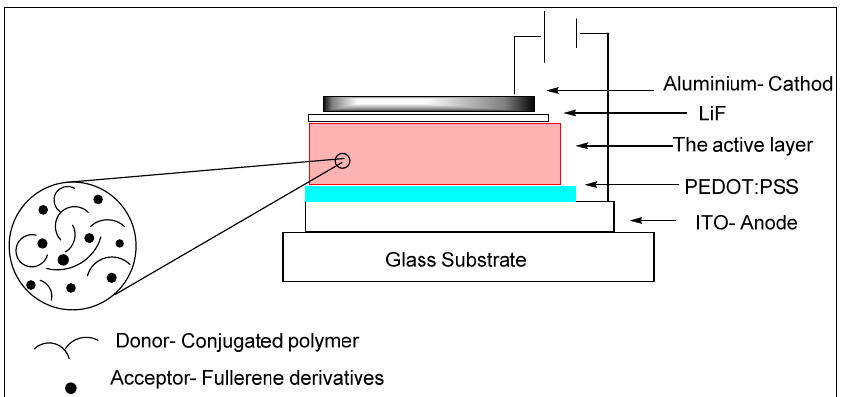
Figure 10. Schematic device structure of the OPV (glass/ITO/PEDOT: PSS/ active layer (polymer- fullerene bulk)/Li/Al).